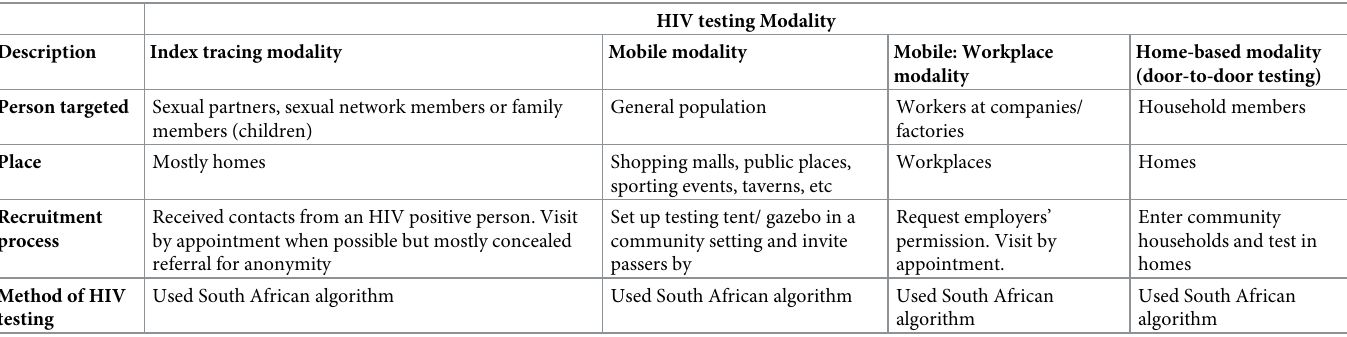
Table 1. Basic characteristics of the index tracing and other